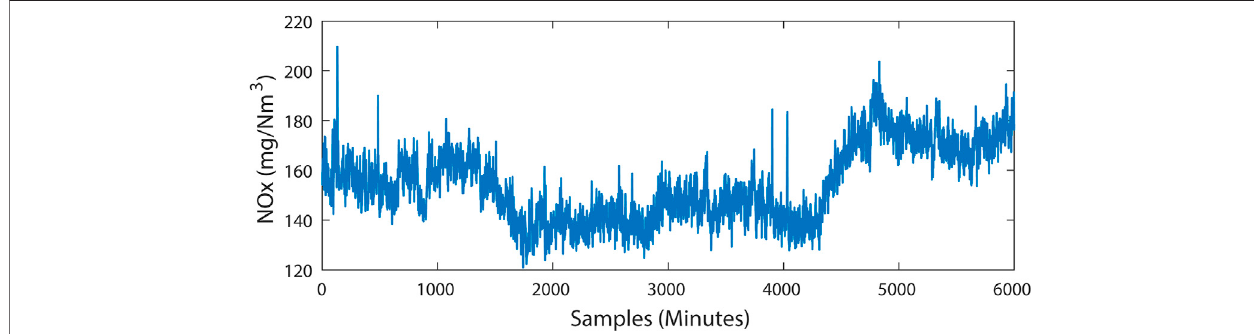
FIGURE 2 | Boiler NOx emissions concentration.